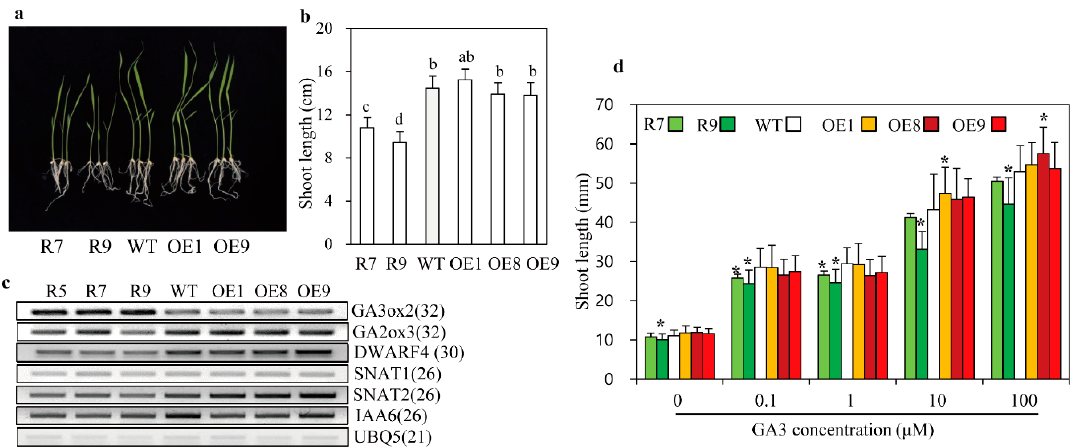
Figure 3. Gibberellic acid (GA) and brassinosteroid (BR) biosynthetic gene expression levels and GA sensitivity assay. ( a ) Phenotypes of various rice seedlings grown for 7 days. ( b ) Shoot lengths. ( c ) Expression levels of GA and BR biosynthetic genes determined by reverse transcription-polymerase chain reaction (RT-PCR). ( d ) Shoot lengths of GA-treated seedlings. Rice seedlings were grown for 7 days in half-strength MS medium ( a – c ). Rice seeds were grown at various concentrations of GA 3 after pretreatment with the GA biosynthesis inhibitor paclobutrazol (PAC) ( d ). Different letters and asterisks indicate significant differences as determined by a post-hoc Tukey’s HSD test at p < 0.05. GenBank accession numbers are AB056519 ( GA3ox 2), AK101713 ( GA2ox3 ), Os03g12660 ( DWARF 4), and Os03g13170 ( UBQ5 ). Numbers in parentheses indicate the number of PCR cycles.